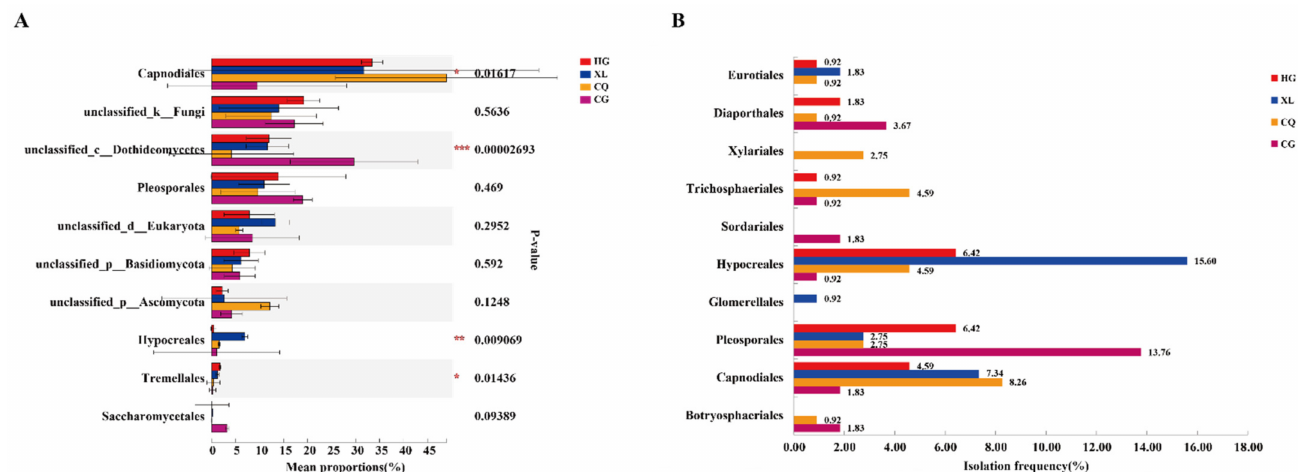
Figure 5. The relative abundance of the most abundant endophytic fungi in four mulberry cultivars. ( A ) The 10 most abundant fungal orders in four mulberry cultivars based on ITS amplicon sequencing. ( B ) Taxonomic distribution (order- level) of isolates from four mulberry cultivars samples based on the culture-dependent method. Different colors represent different groups. *** p < 0.001, ** p < 0.01, * p < 0.05. One-way ANOVA and p -value were corrected by the FDR method. The isolation frequency (IF) was calculated using the formula: IF (%) = the number of isolates of a certain taxa/the total number of isolates ×